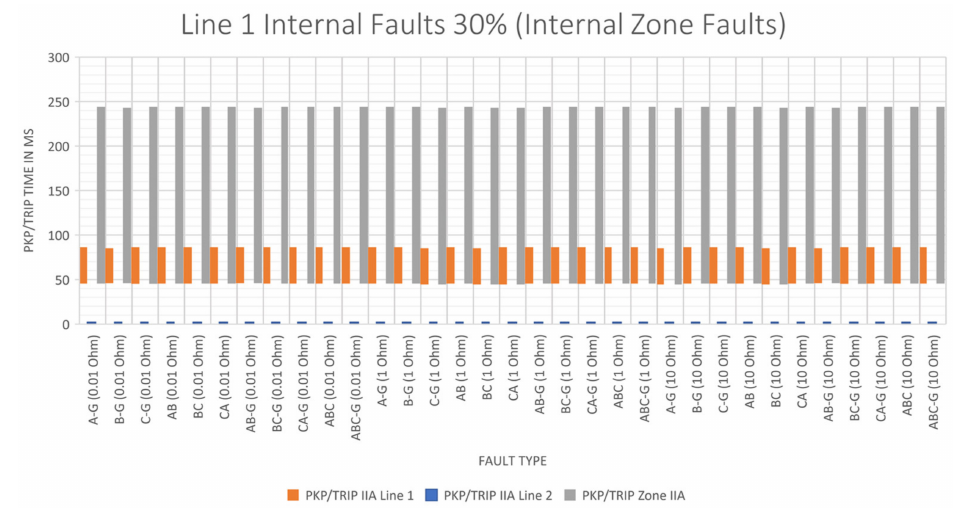
Figure 22. Internal line faults in Line 1 (30%); four reactors.